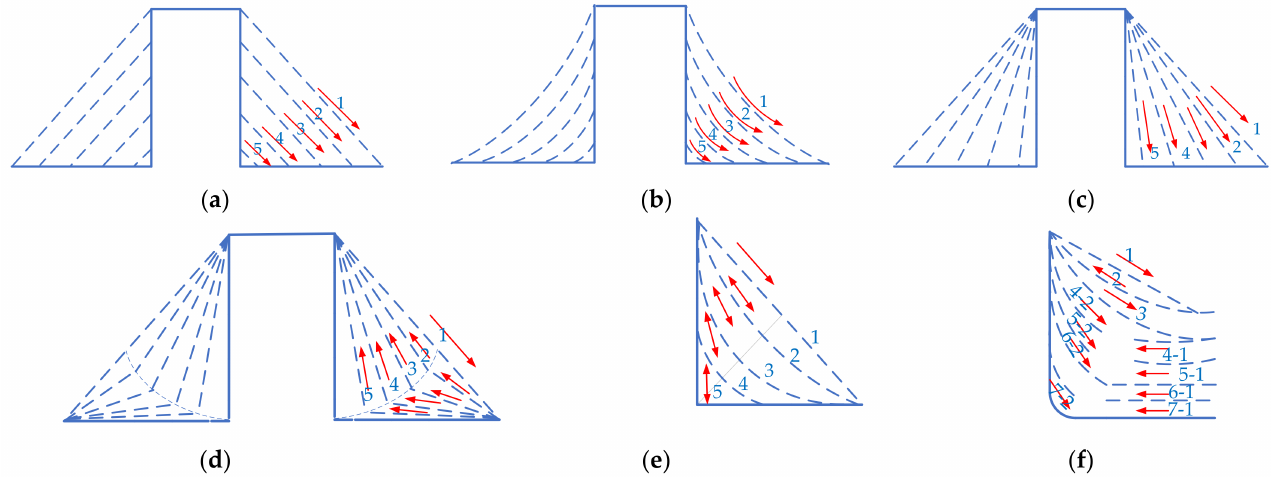
Figure 1. Toolpath strategies: ( a ) parallel straight line; ( b ) translation arc line; ( c ) variable angle type; ( d ) stretch-bending assisted forming; ( e ) five steps forming; and ( f ) forming based on Out-to-In (OI)